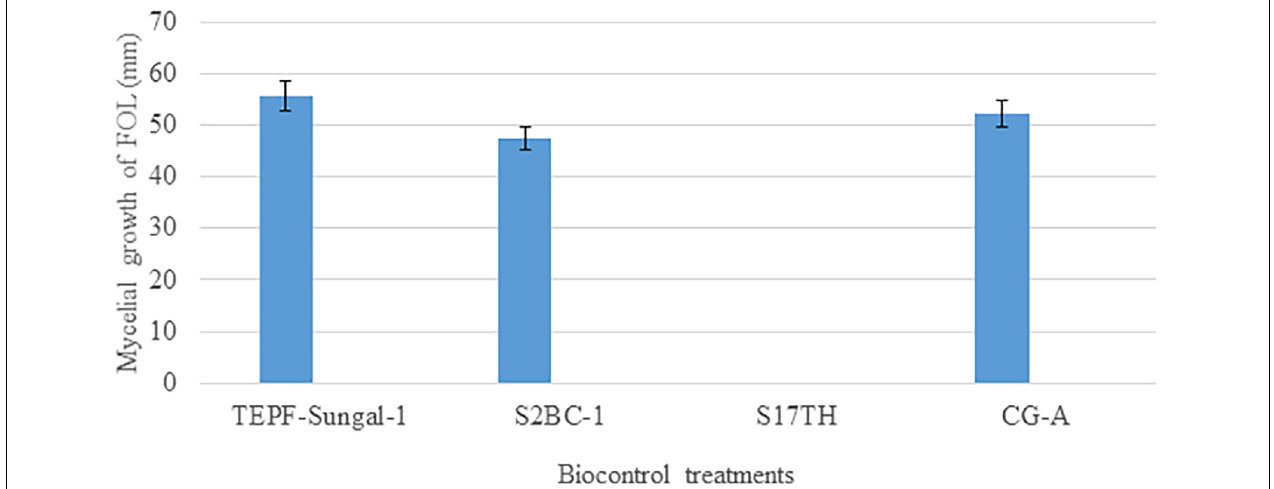
FIGURE 5 | Antagonism of the candidate biocontrol strains against the Fusarium oxysporum strain, TOFU- IHBT in dual culture assay. No mycelial growth of the pathogen was observed in the dual culture assay with the Trichoderma harzianum strain S17TH. Error bars indicate Standard Deviation (SD). TABLE 3 | Polyhouse evaluation of biocontrol strains to manage Fusarium wilt of tomato. Cell suspension